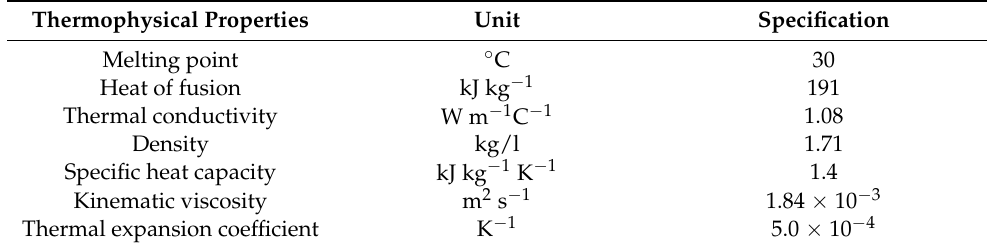
Table 3. Thermophysical properties of the PCM (calcium chloride hexahydrate CaCl 2 .6H 2